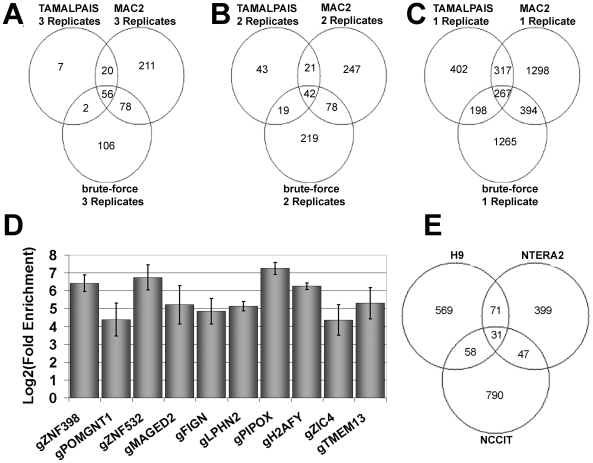
Influence of peak finding algorithms on binding sites.Venn diagrams, illustrating the overlaps between different peak analysis programs. A–C: sorted replicate-wise. D: Real-time PCR validation, showing relative enrichment values for 2 non-amplified biological replicates. Ten randomly chosen peak regions, identified by our peak analysis were chosen for this analysis. ZNF398, POMGNT1, ZNF532 and MAGED2 were identified by all three algorithms. FIGN and LPHN2 were only detected by brute-force. PIPOX and H2AFY were only detected by MA2C. TMEM139 and ZIC4 were only detected by TAMALPAIS. E: Venn diagram, showing the overlap between different cell lines- NCCIT, this study, H9 [3] and NTERA2 [13].